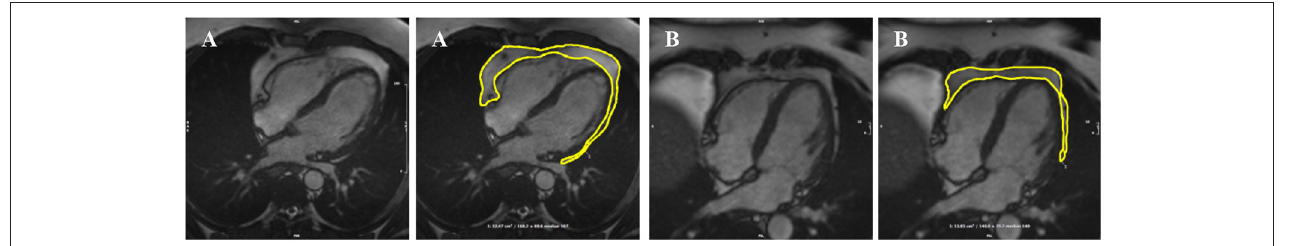
FIGURE 1 | Two examples of PAT contoured in end-diastole on four-chamber bSSFP cine-CMR, performed using CVI 42® software according to the established SOP. A single contour was drawn to select areas of high signal intensity adjacent to the epicardial surface of the left and right ventricles, resulting in output of an area measure (A) . Areas of high signal intensity over the liver were not included in the PAT measure as this almost always represents adipose tissue below the diaphram (B) . bSSFP, balanced steady state free precession; CMR, cardiovascular magnetic resonance; PAT, pericardial adipose tissue; SOP, standard operating procedure. Images reproduced with permission of UK Biobank ©